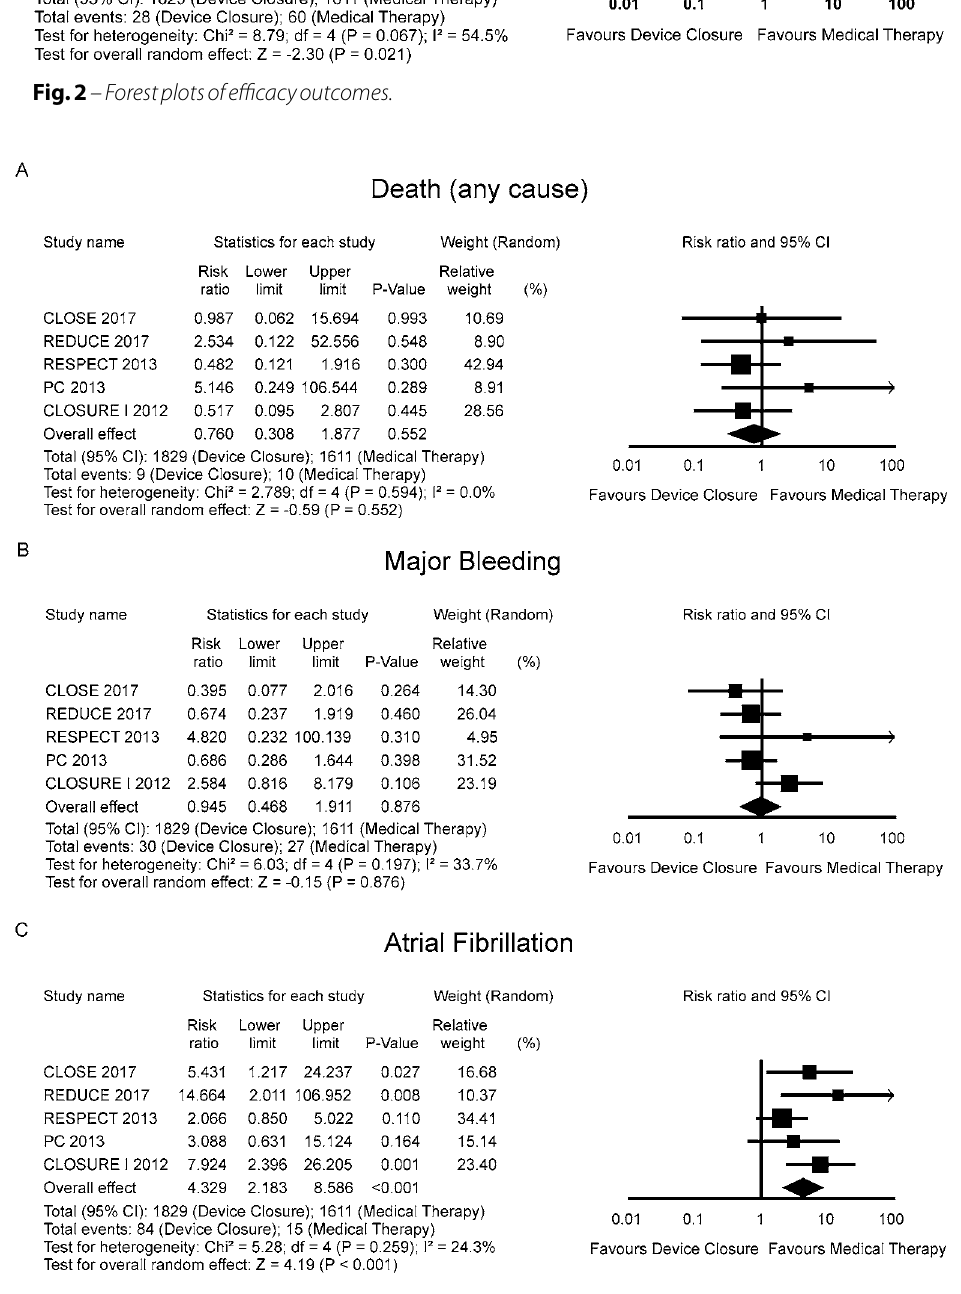
Fig. 3 – Forest plots of safety